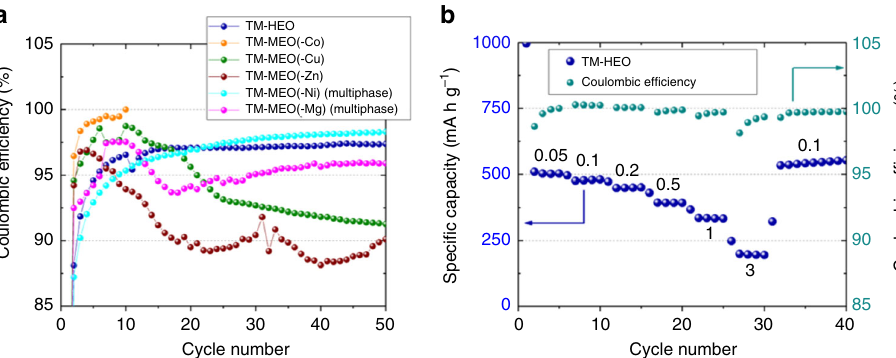
Fig. 5 Coulombic ef fi ciencies of the TM-MEO and TM-HEO compounds and rate test of a higher-loaded TM-HEO electrode. a Coulombic ef fi ciency vs. cycle number for all the tested electrode materials at 50 mA g ‒ 1 . Only TM-HEO reveals stable cycling behavior. The multiphase material without Ni exhibits comparable ef fi ciencies, but with much lower speci fi c capacities (below 250 mAh g ‒ 1 after 40 cycles) (Supplementary Figure 4). b Rate performance test performed on a TM-HEO cell with an overall higher loading (2.3 mg TM-HEO cm ‒ 2 ). The current values in b are given in units of A g ‒